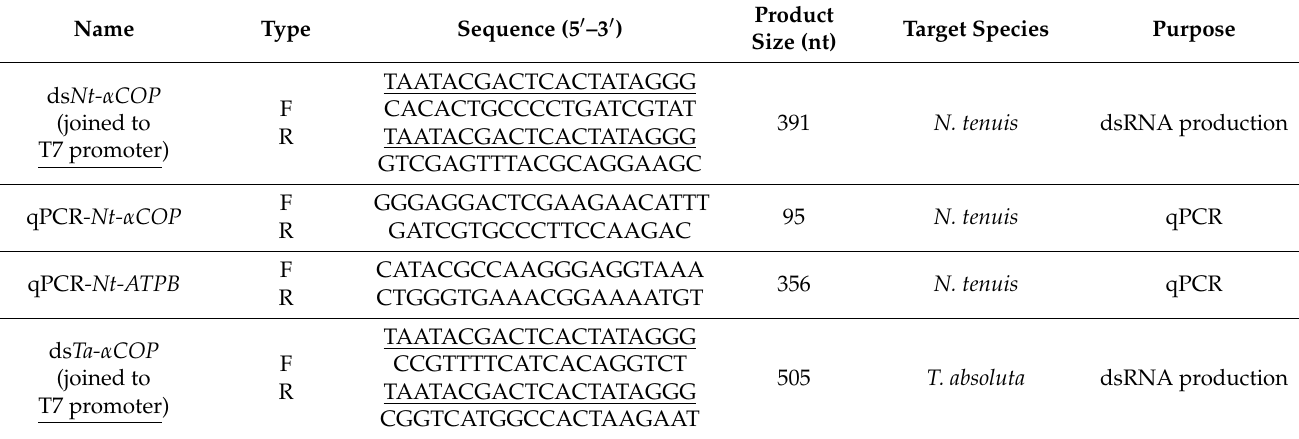
Table 1. Primers designed in this study for in vitro production of dsRNA and gene expression analysis in Nesidiocoris tenuis and Tuta absoluta